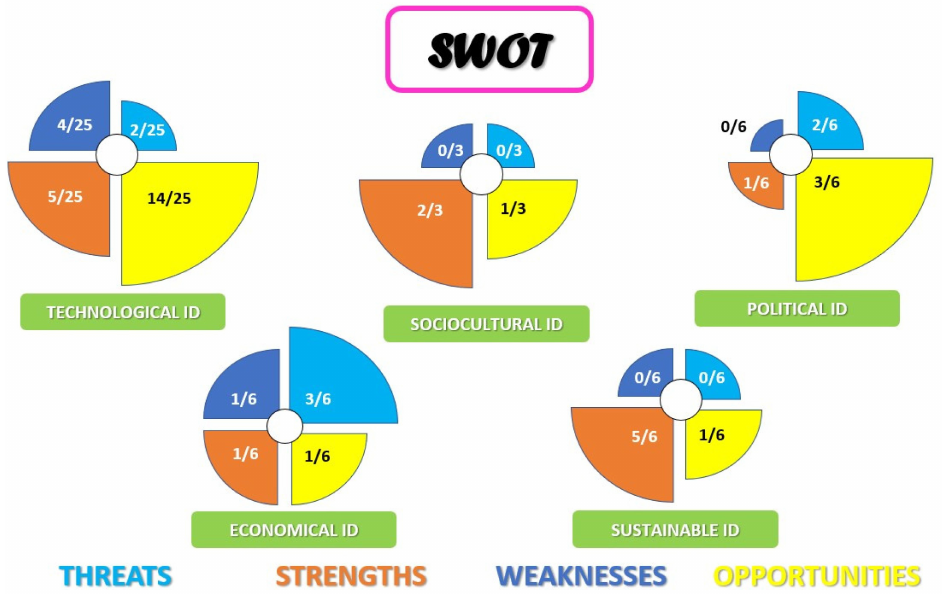
Figure 11. SWOT macro-environment by ID indicators. Source: own elaboration.